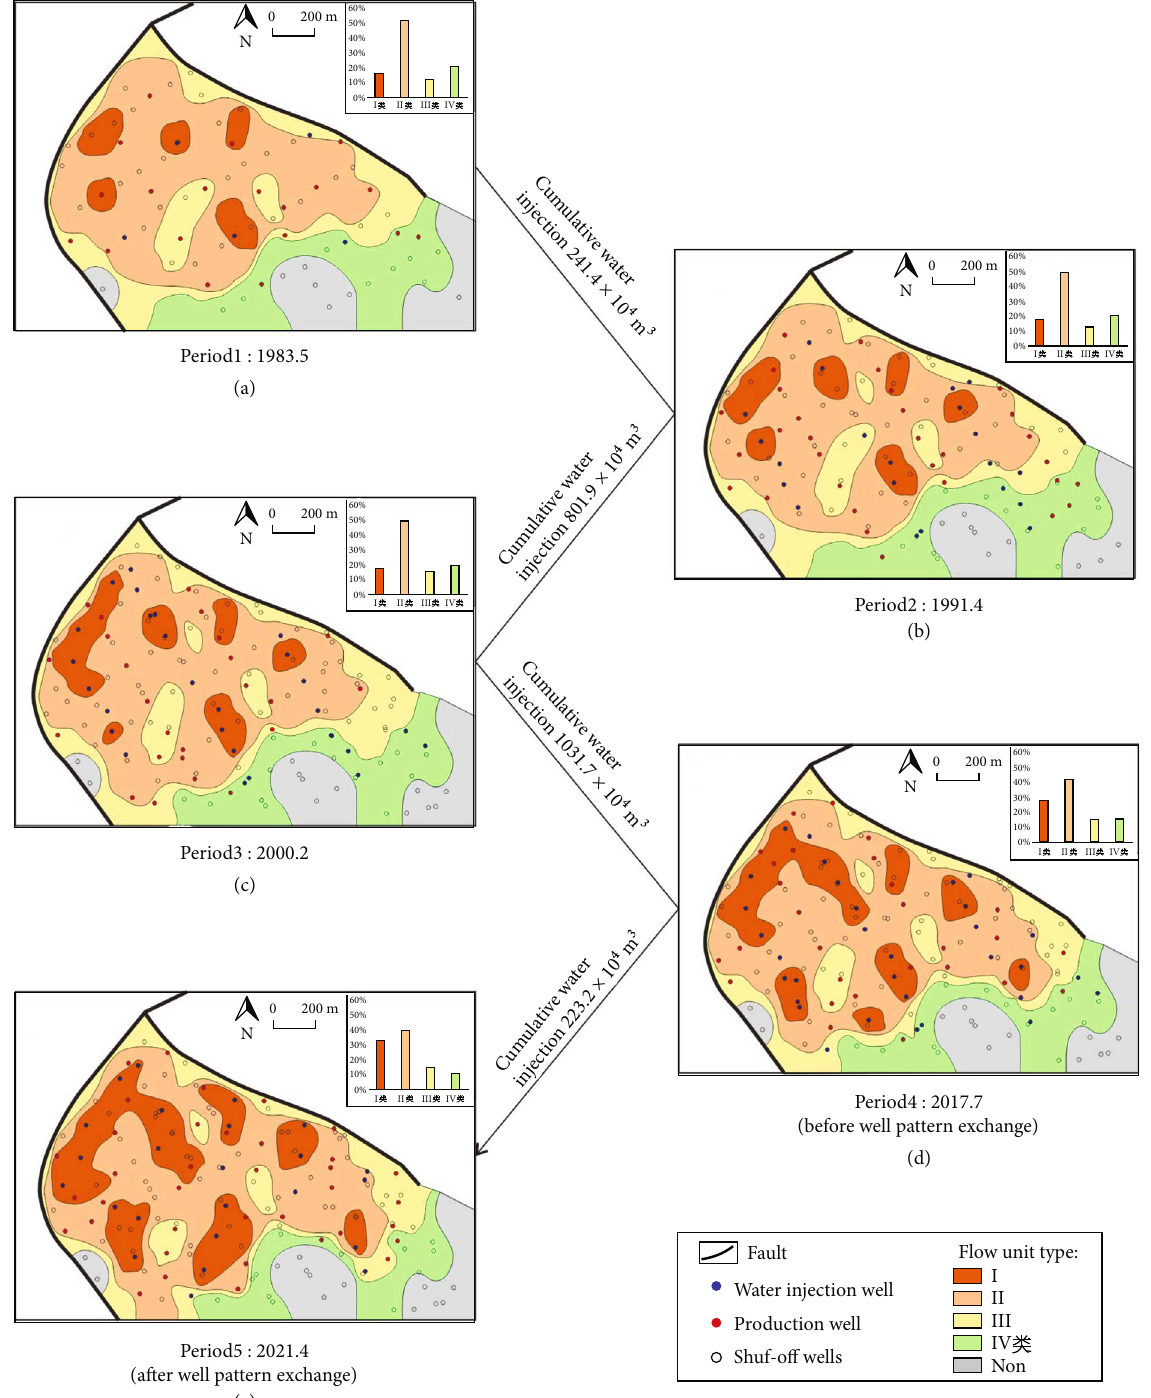
Figure 12: Plane distribution of various types of fl ow units in di ff erent